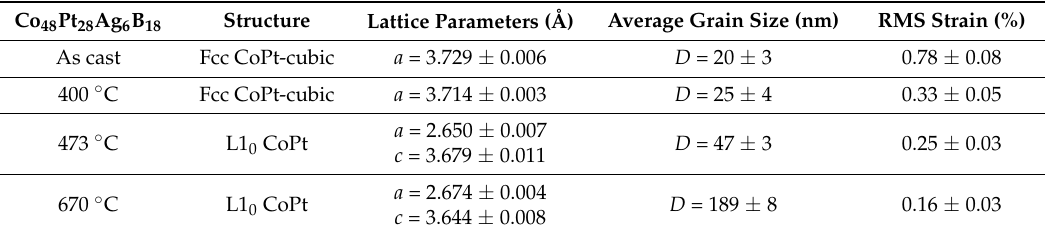
Table 1. Lattice parameters, average grain sizes obtained from full-profile MAUD